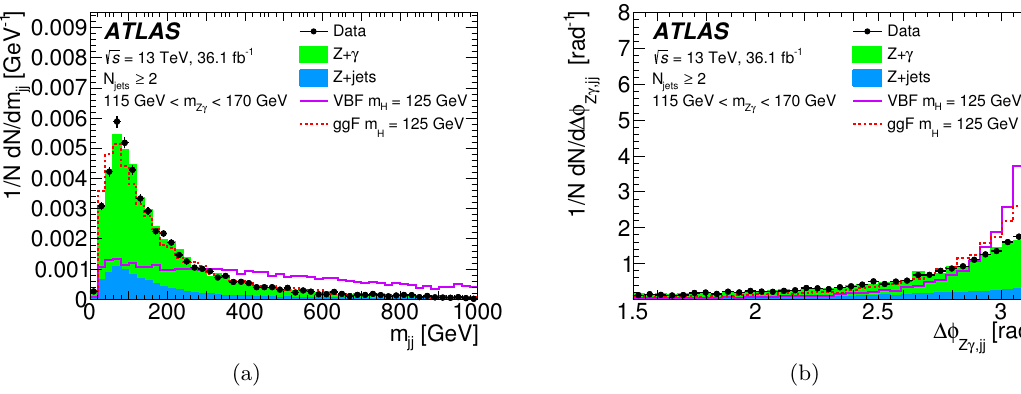
Figure 2 . Kinematic variables used in the BDT used to de(cid:12)ne the VBF-enriched category: (a) the invariant mass of the two jets with the highest transverse momenta, m jj and (b) the azimuthal separation of the Z(cid:13) and the dijet system, (cid:1) (cid:30) Z(cid:13);jj for events with at least two jets and 115 GeV < m Z(cid:13) < 170 GeV. The observed distribution (normalised to unity) is shown as data points. The contributions from Z + (cid:13) events (obtained from simulation) and the contribution from Z +jets (obtained from data control regions described in the text) are shown as stacked histograms. The corresponding expected distributions for Higgs bosons produced via gluon-gluon fusion and vector- boson fusion production for m H = 125 GeV are shown as open histograms. The (cid:1) (cid:30) Z(cid:13);jj distribution is shown before the suppression of the shape information for (cid:1) (cid:30) Z(cid:13);jj > 2 : 94.